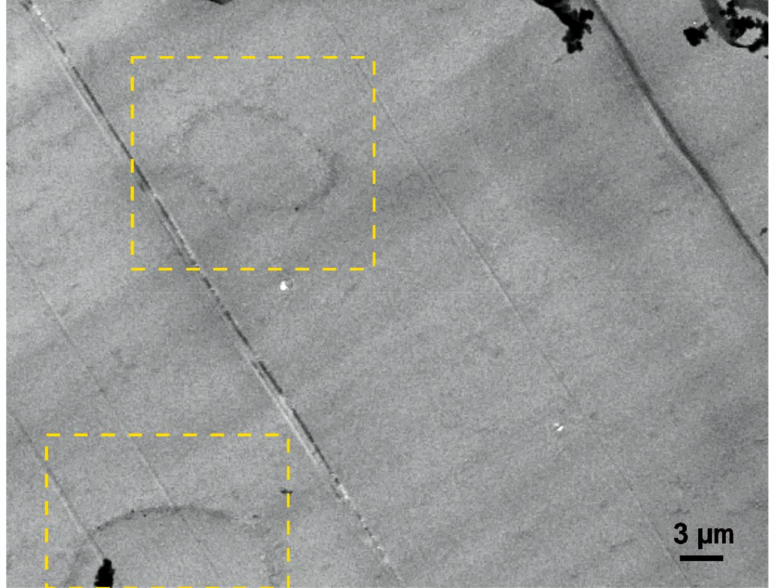
Figure 2. 10 kV scanning electron micrograph in transmission mode (TSEM) in different regions of the epoxy composite containing PC neat fibers. The regions in the yellow squares signalize interstices or crossing points of collapsed PC fibers, the rounded regions are filled with epoxy resin. The original image can be found in the Appendix C Figure